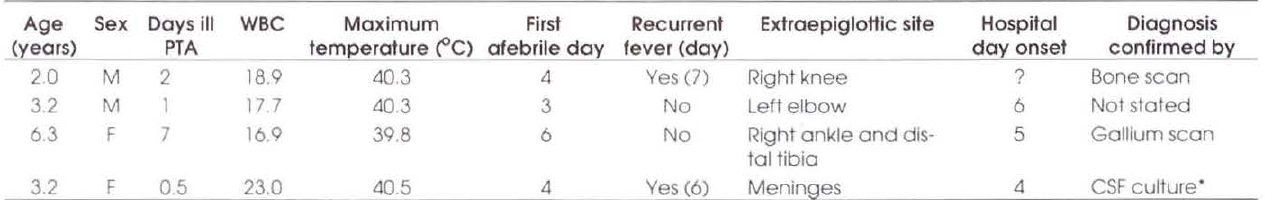
Clinical data for four c hildren with a second invasive focus of infection accompanying